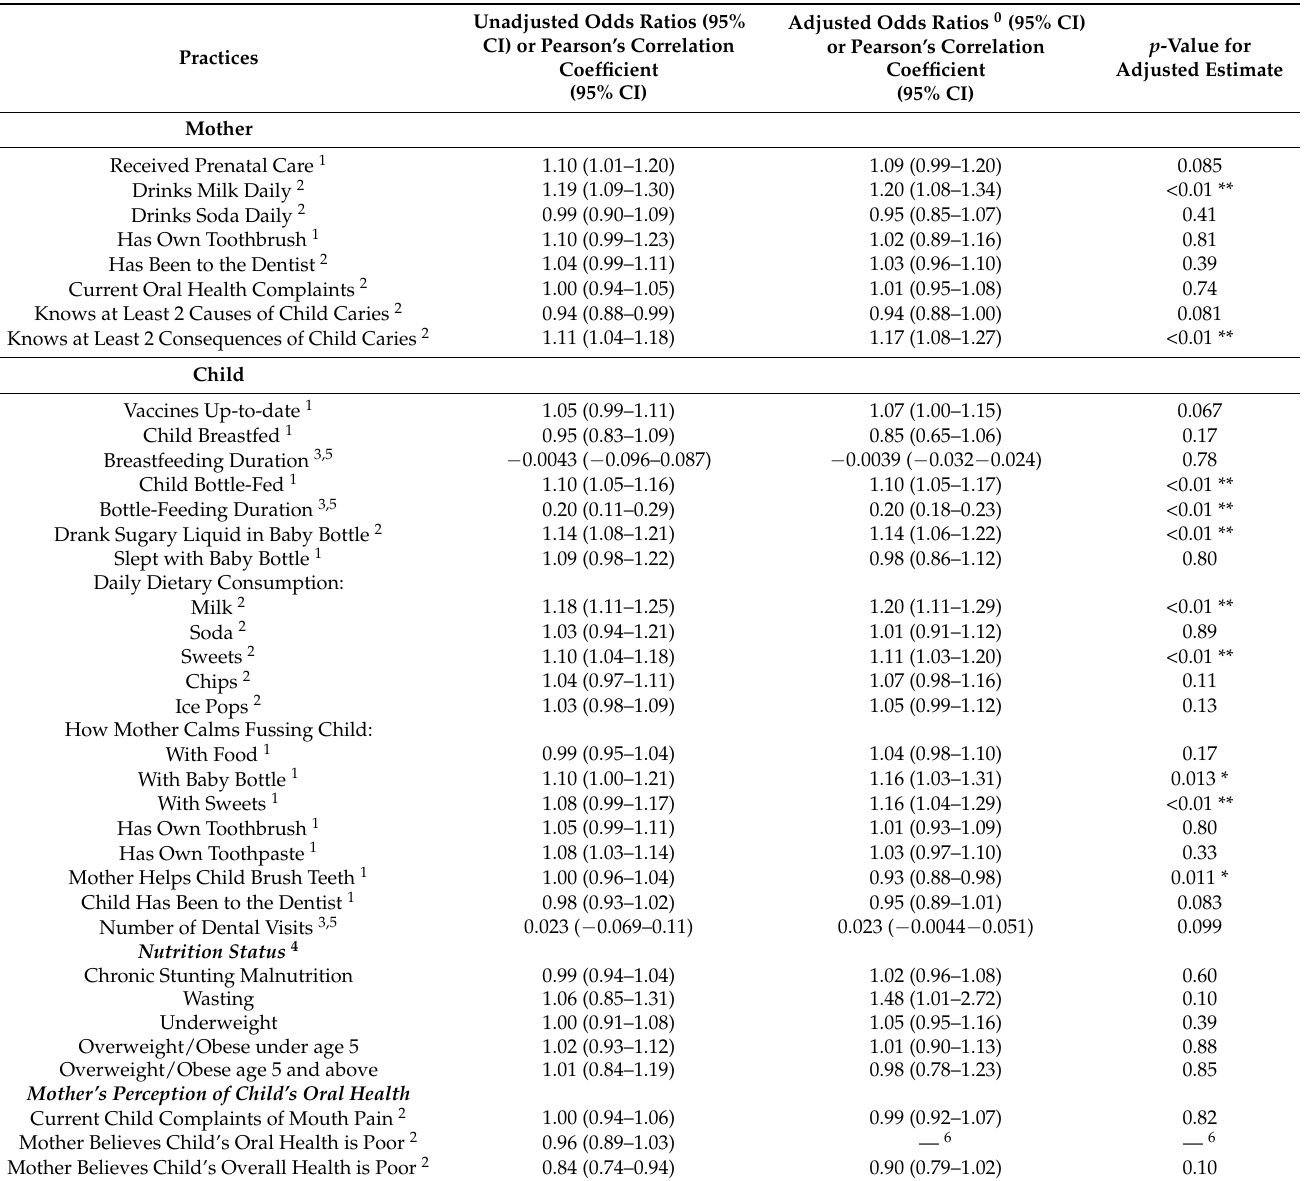
Table 4. Relationship between Years of Maternal Education and Maternal-Child Oral Health